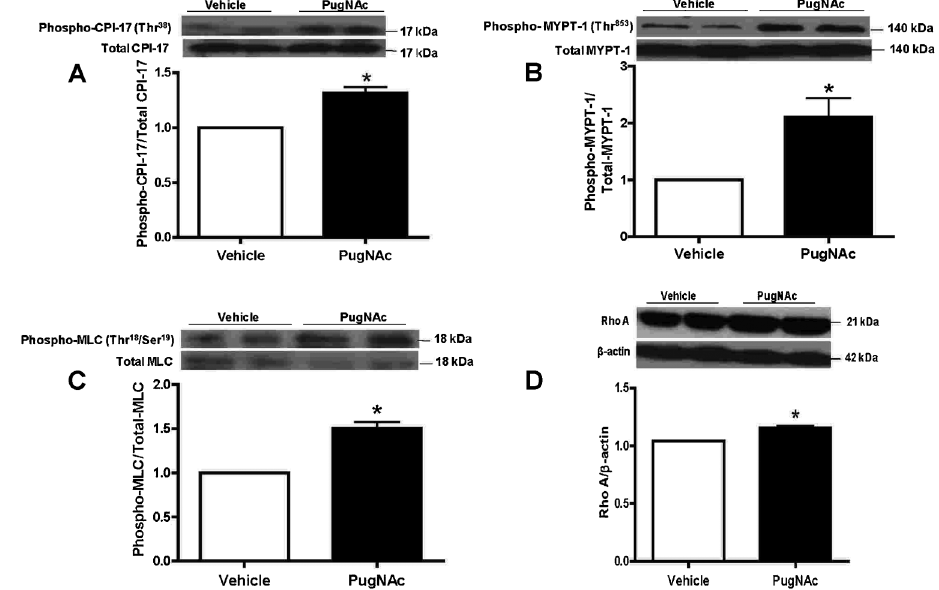
Figure 3. PugNAc increased expressions of phospho-CPI-17 (Thr 38 ), phospho-MYPT-1 (Thr 853 ), phospho-MLC (Thr 18 /Ser 19 ) and RhoA in rat aorta. PugNAc incubation did not change expression of total CPI-17 ( A ), MYPT-1 ( B ), or MLC ( C ), but increased expression of the phosphorylated forms of CPI-17 (Thr 38 ) ( A ), MYPT-1 (Thr 853 ) ( B ), MLC (Thr 18 /Ser 19 ) ( C ), and RhoA expression ( D ). Data are reported as means±SE of the relative expression of phosphorylated forms of CPI-17 (Thr 38 ), MYPT-1 (Thr 853 ), and MLC (Thr 18 /Ser 19 ) after normalization to the corresponding total protein expression ( A , B , C ) or the relative expression of RhoA after normalization to b -actin expression ( D ) (n=6). *P , 0.05 vs vehicle (10 m L/mL methanol, vehicle to PugNAc) (Student t -test).